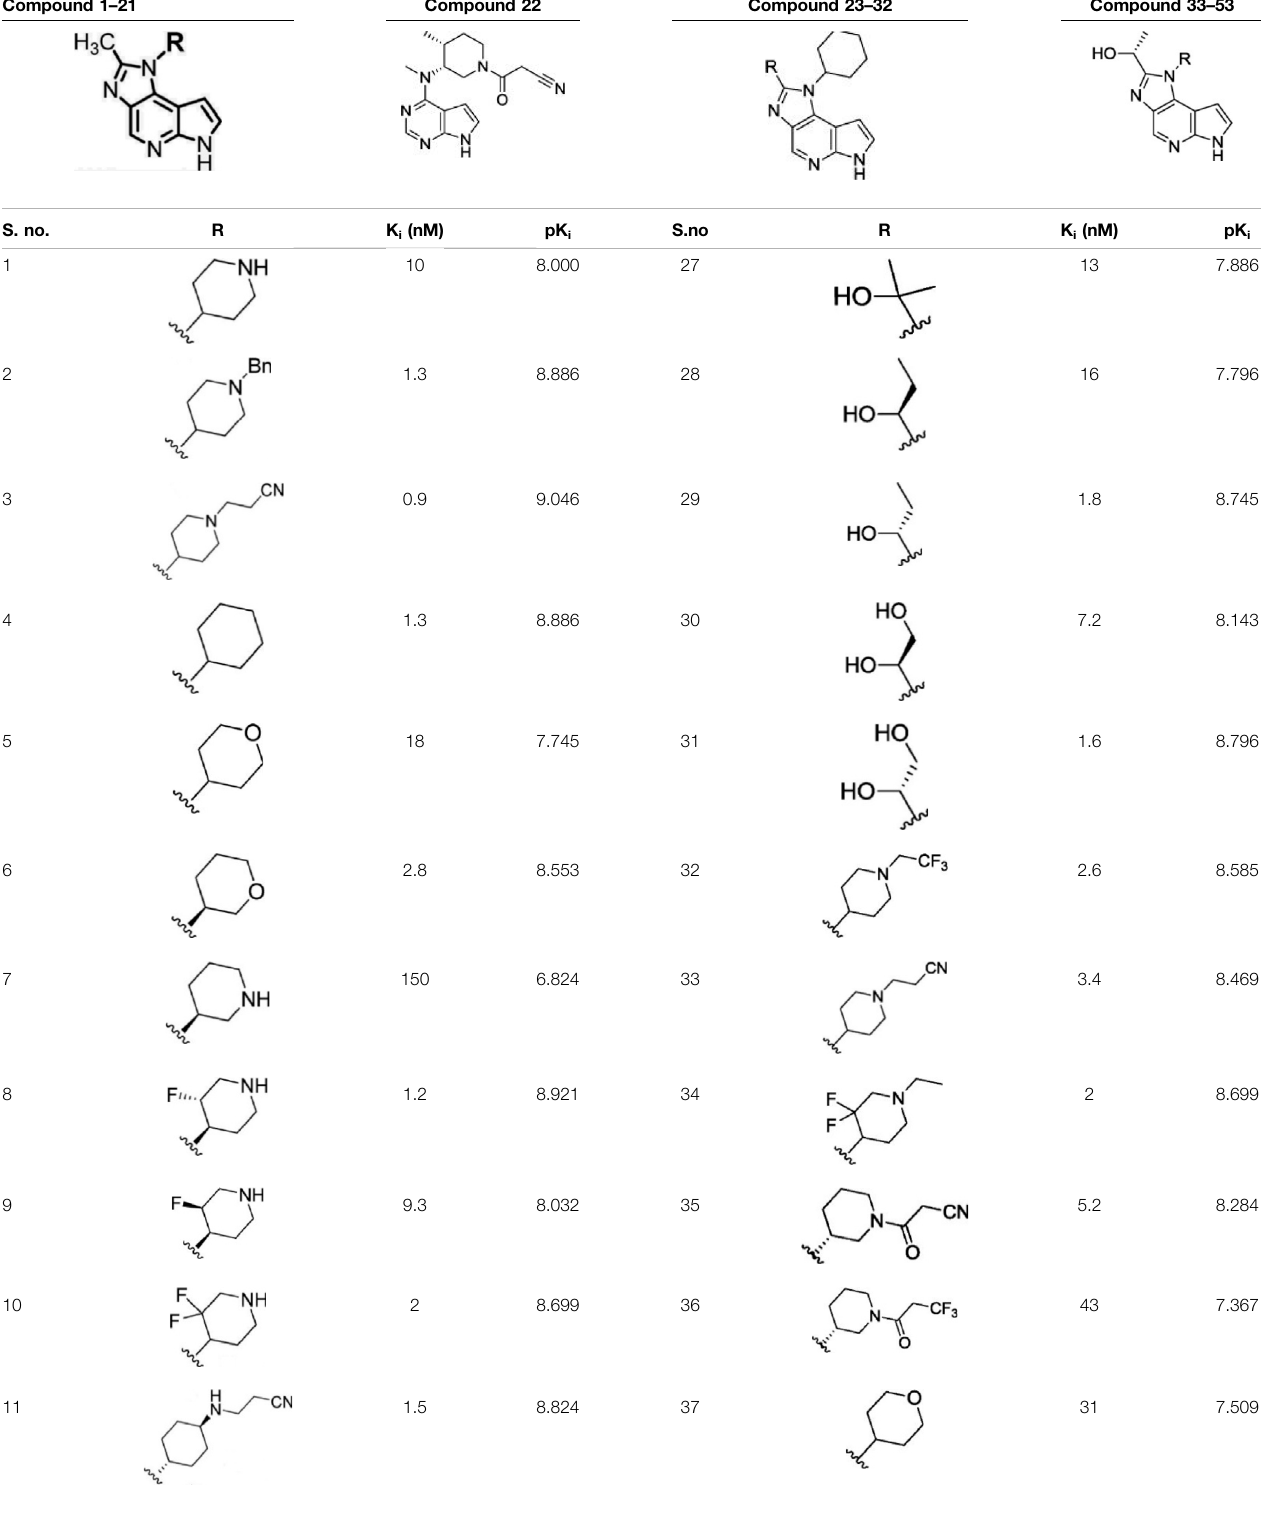
TABLE 1 | The chemical structures and the biological activity of JAK1